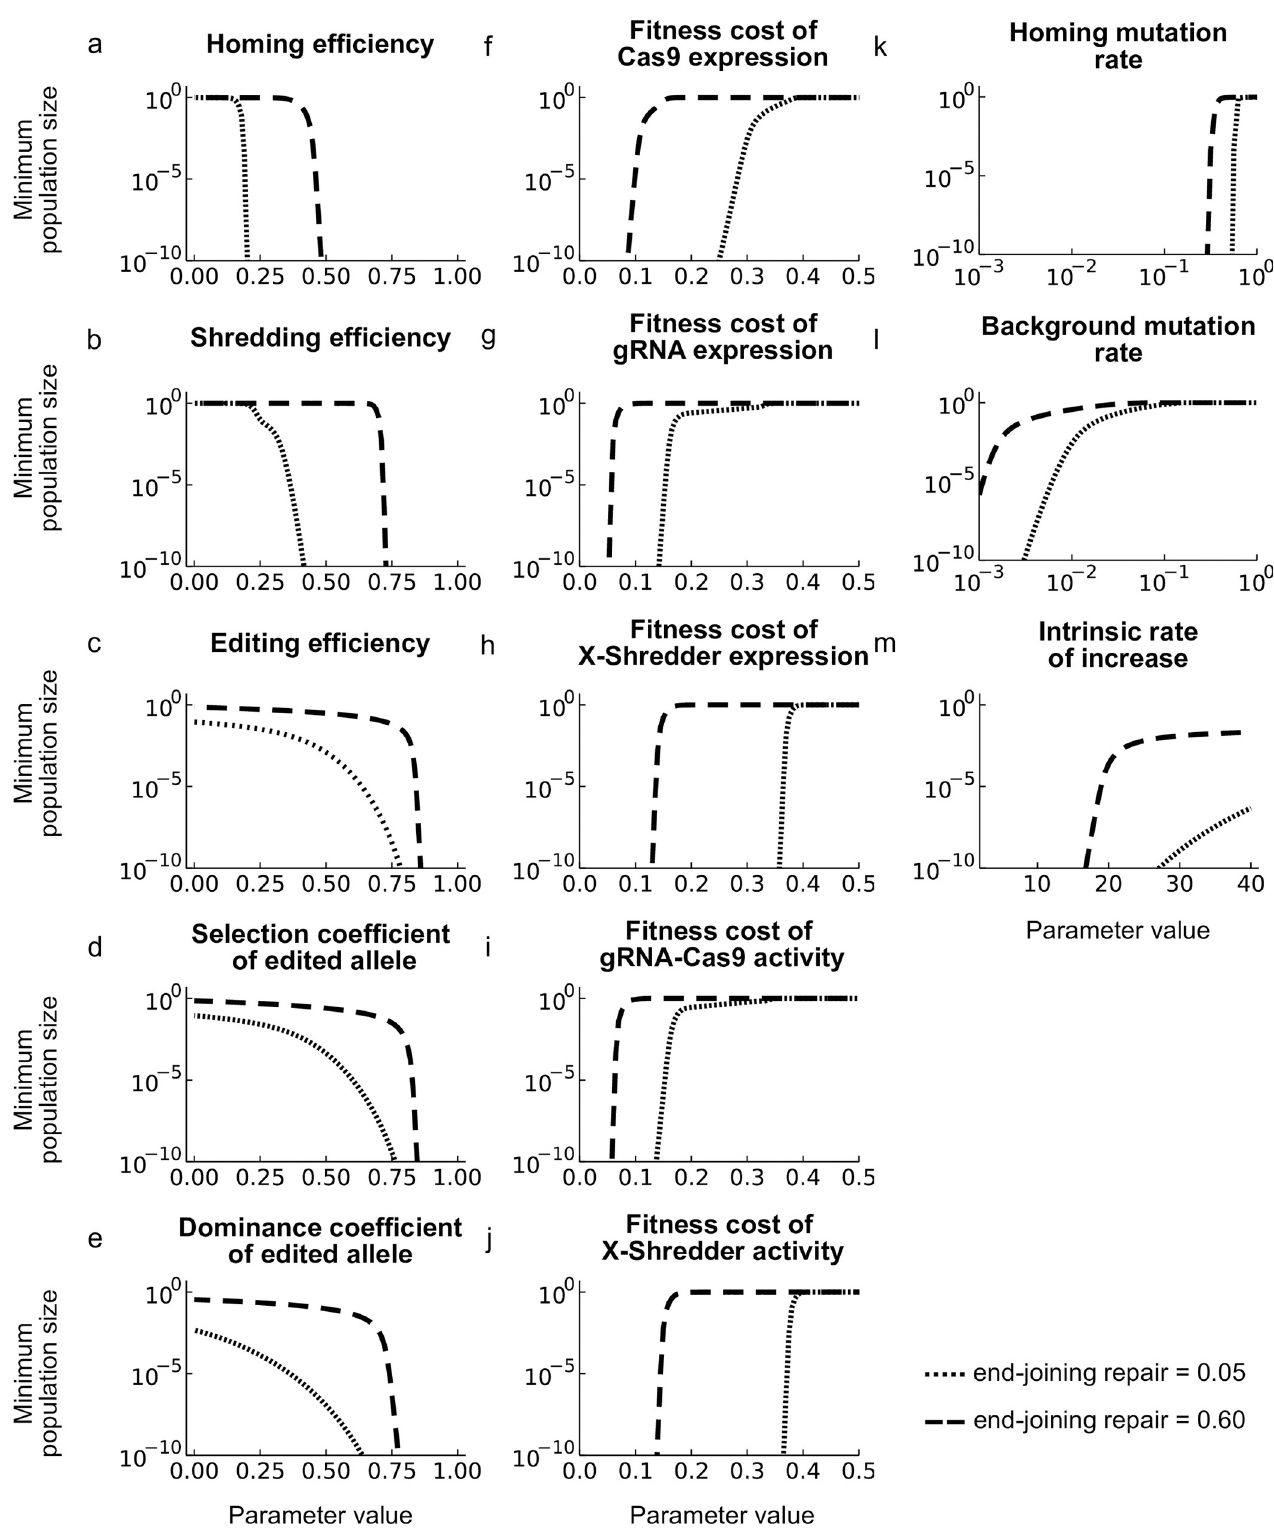
Fig 4. Sensitivity analysis. Each plot shows the minimum population size as a function of changes in the specified parameter assuming low EJR (5%; dotted lines) or high (60%; dashed lines). Note for (a) that the homing rate is equal to (cleavage rate) x (1-end joining rate).